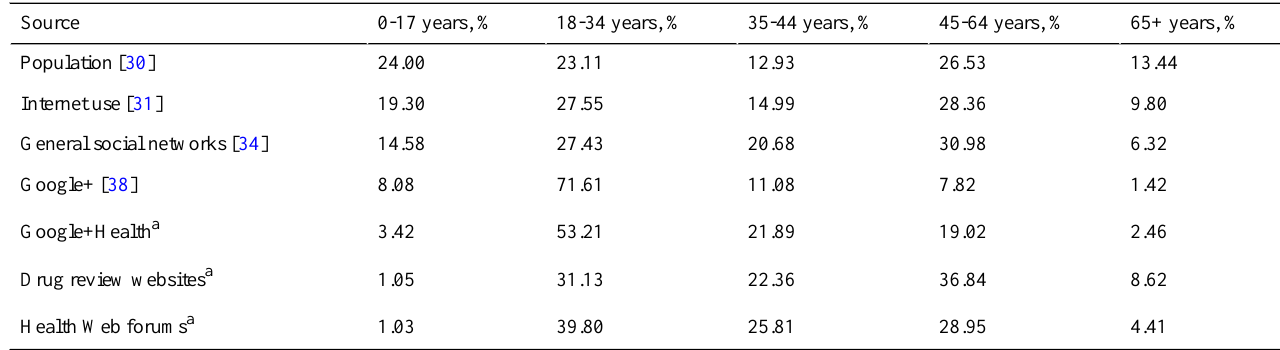
Table 4. Age distribution for Google+Health, drug reviews, health forums, and other relevant